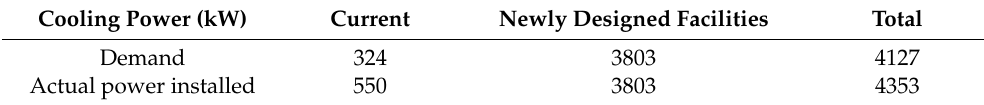
Table 4. Cooling power requirements.